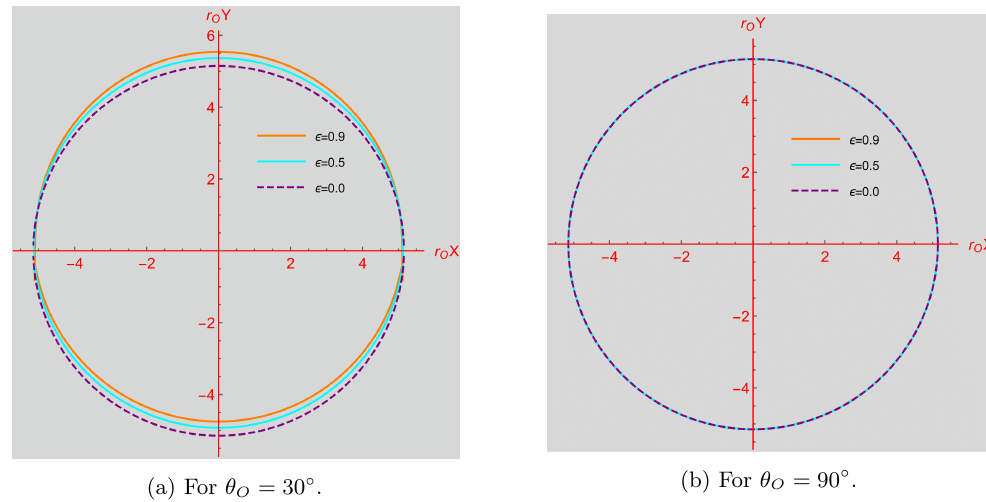
Figure 3 . Shadow of a black hole with soft hair C ∼ E Y 20 . The coordinates are in unit of r g . The observer is situated at r O = 100 M . This analytical shadow is parametrized by X and Y defined by (B.2). The method for analytical construction of the shadow is also described in appendix